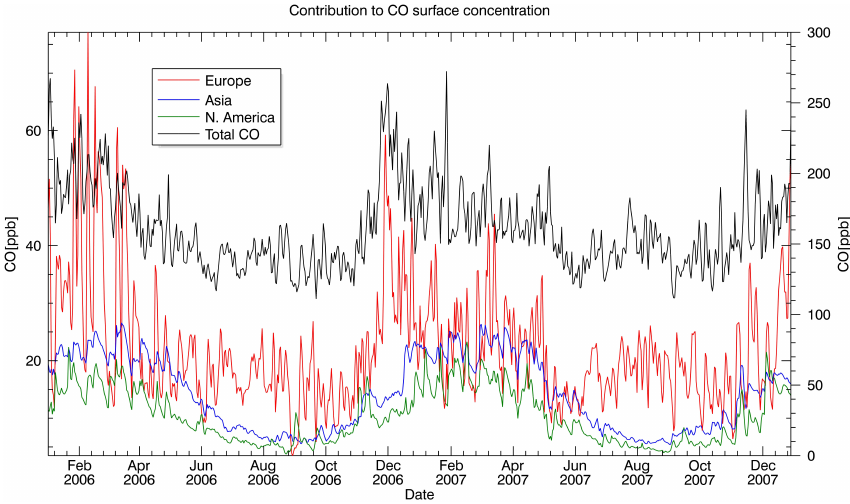
Fig. 11. The contribution of CO anthropogenic sources for each continent for 2006–2007. During Summer: European sources are dominant, with high daily variation. CO from Asia and North America has a small contribution and very small daily